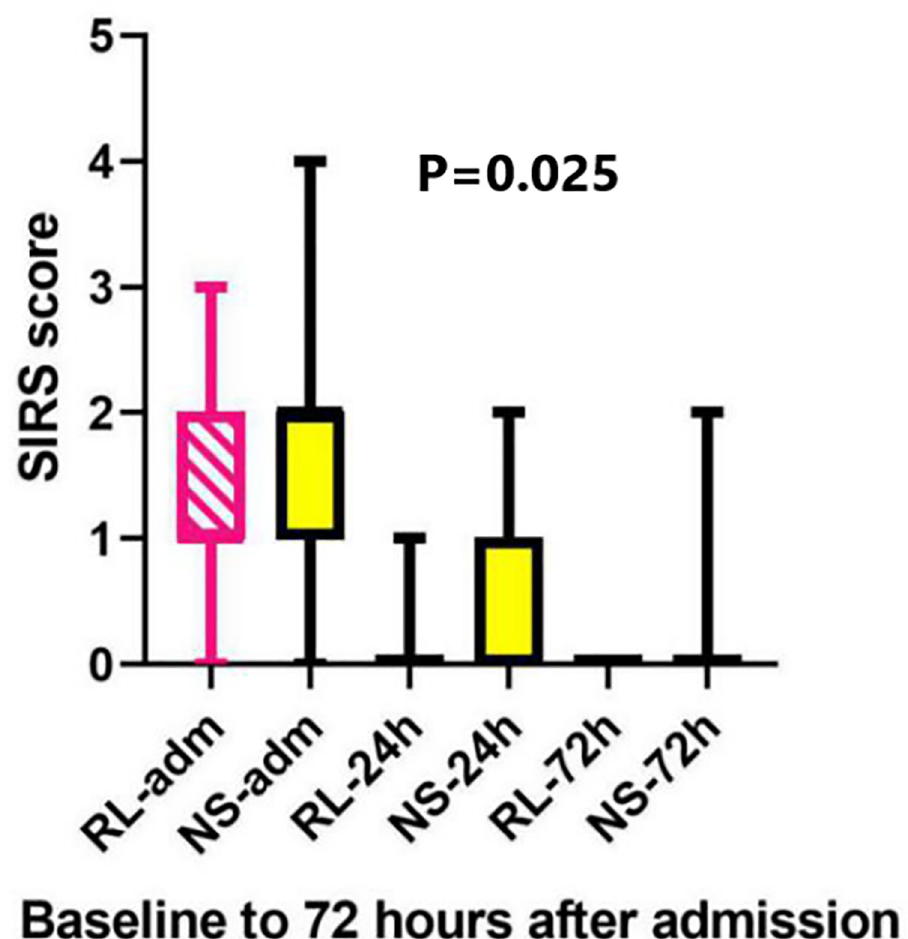
Fig 3. Box plot presentation of SIRS score in two groups. RL-adm: Ringer Lactate group at admission, RL-24 h: Ringer Lactate group at 24 hours, RL-72h: Ringer Lactate group at 72 hours, NS-adm: Normal Saline group at admission, NS-24h: Normal Saline group at 24 hours, NS-72h: Normal saline group at 72 hours.